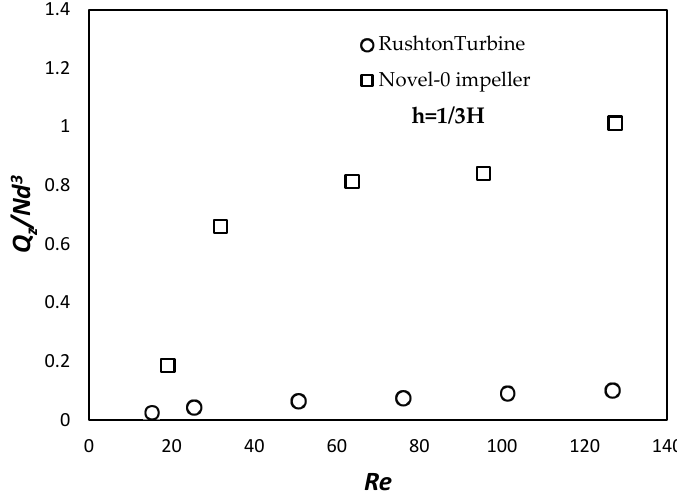
Figure 9. Normalized pumping capacity Q z evaluated from experimental measurements as a function of the Reynolds number and for h = 1 / 3 H .